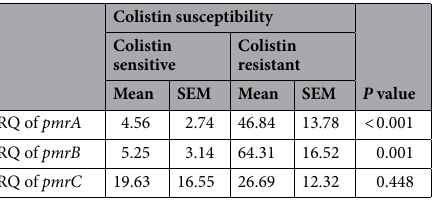
Supplementary Table S1. The Spearman correlation coefficient test revealed a weak positive correlation between the MIC values of colistin and the expression levels of each of pmrA (r = 0.399, P < 0.001) and pmrB genes (r = 0.383, P < 0.001). However, there was insignificant correlation between pmrC expression levels and colistin MICs (r = 0.149, P = 0.139). ROC curve analysis revealed that pmrA expression could differentiate between colistin-susceptible and colistin-resistant isolates showing sensitivity of 63.3% and a specificity of 88.2% at a cutoff value = 2.7105 (AUC 0.713, P < 0.001) (Fig. 2A).